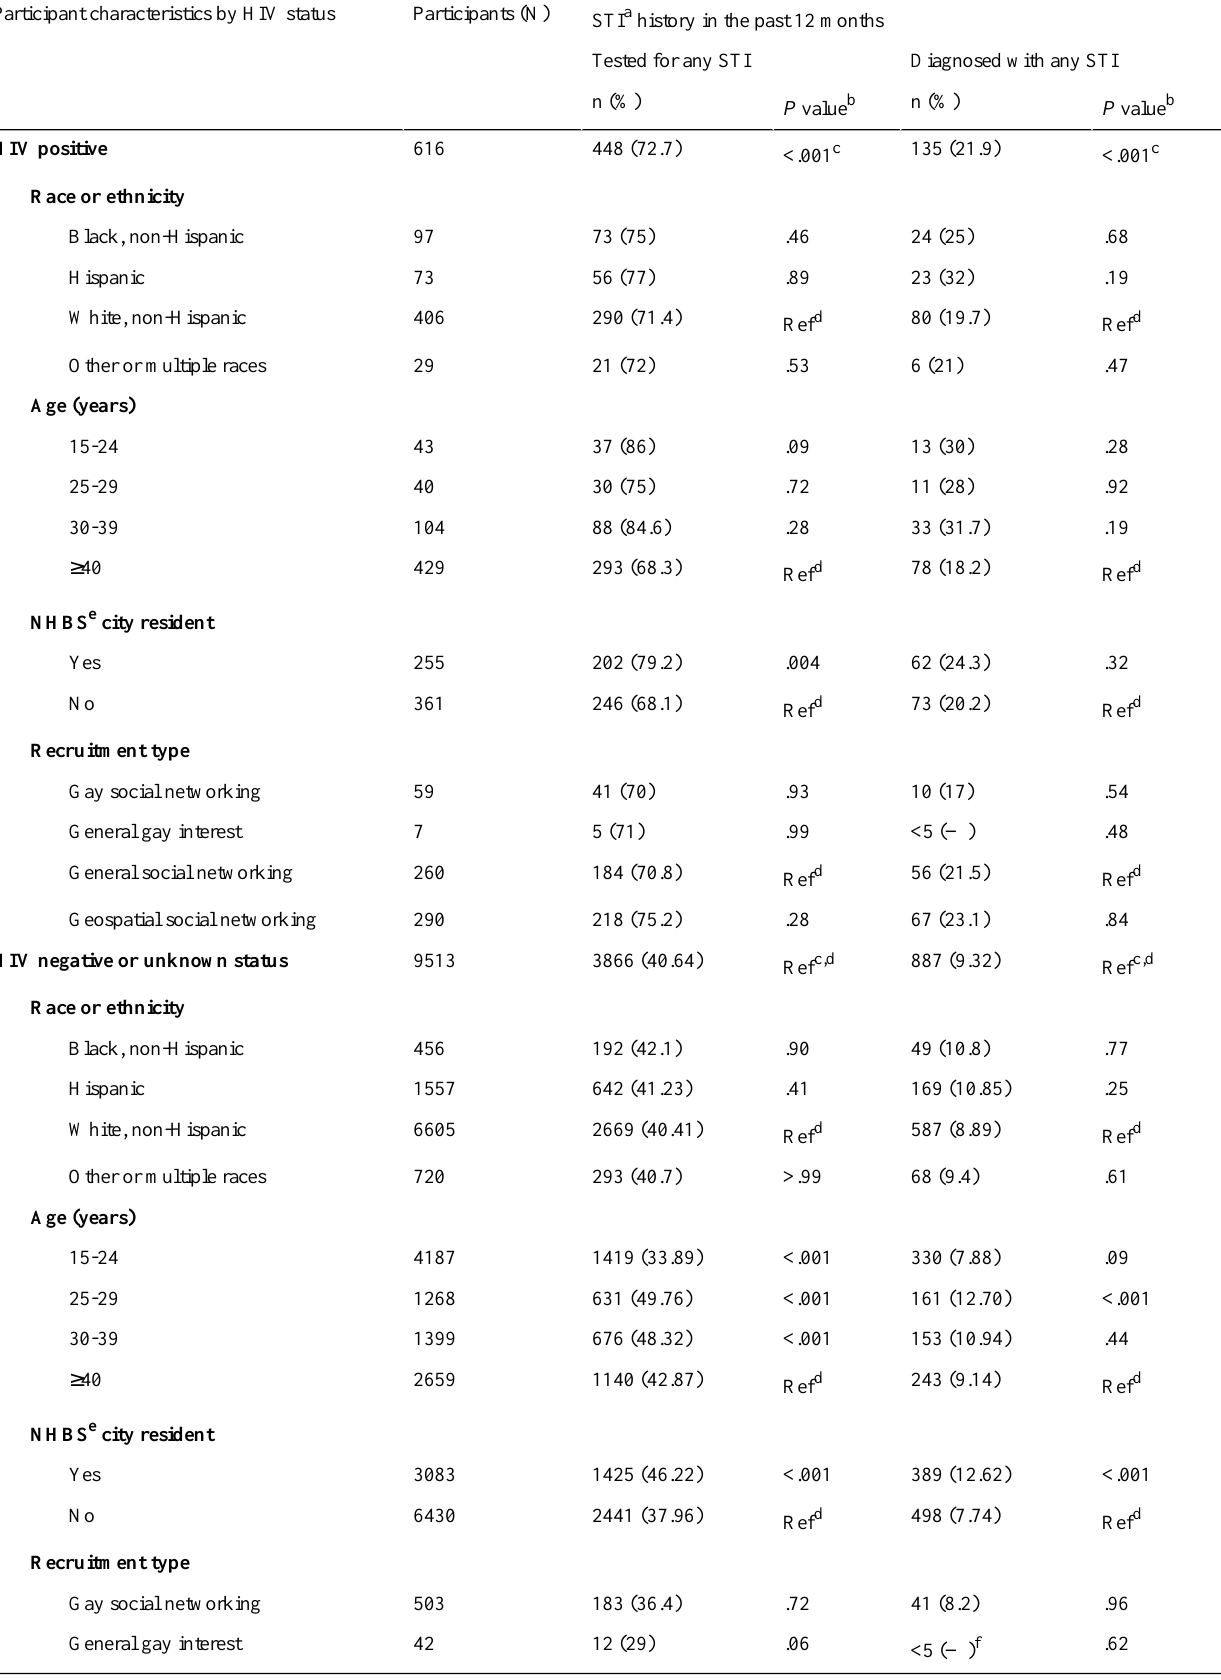
Table 6. Sexually transmitted infection testing and diagnosis of men who have sex with men in the American Men’s Internet Survey, United States,